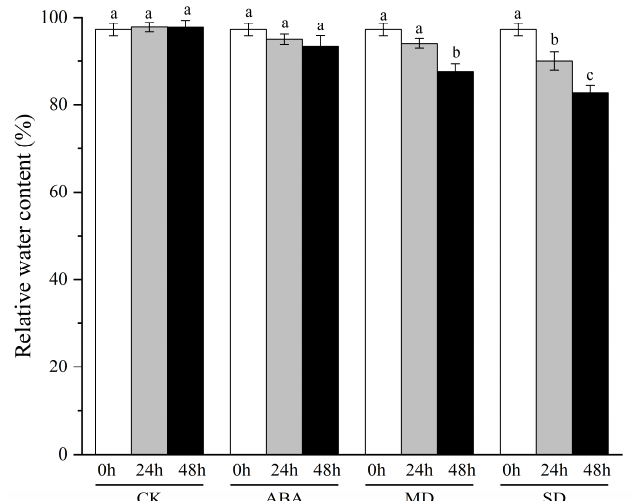
Figure 5. The relative water content of leaves under PEG induced drought stress and ABA treatments. CK, MD, SD and ABA represent the control condition, mild and severe drought and ABA treatments, respectively. The error bars indicated the standard errors of three biological replicates. Lowercase letters indicate significant differences.